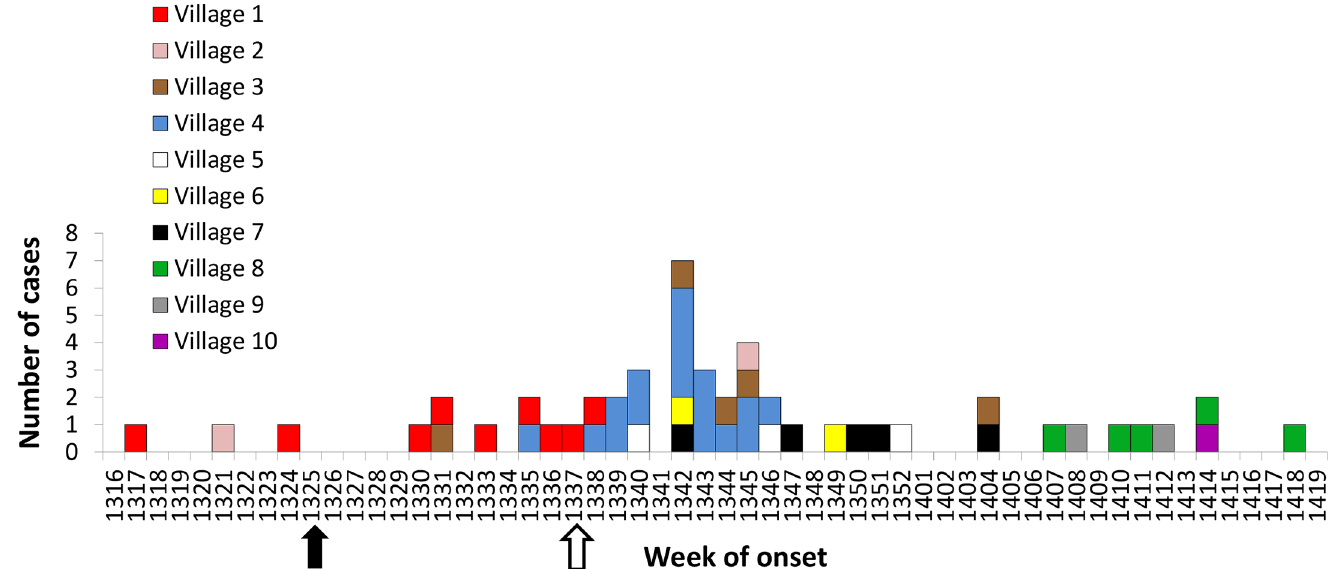
Fig 2. Number of new cases of cryptosporidiosis (n = 51) according to village of residence and CDC week of onset, from April 2013 to April 2014. Week of onset refers to onset of symptoms when known (n = 35) or, if not available, the date of stool specimen collection (available for all cases). The filled arrow denotes the start of routine acid-fast staining for all specimens from Arctic communities; the open arrow denotes the onset of enhanced passive surveillance.